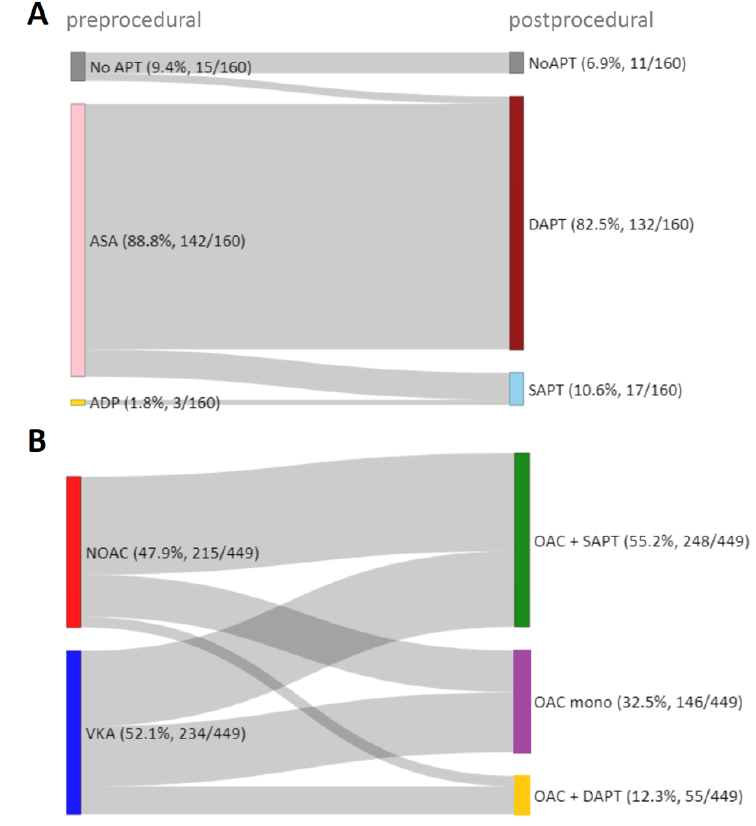
Figure 1. Pre- and postprocedural antithrombotic therapy. Sankey diagram illustrating the pre- and postprocedural antithrombotic therapy in successfully treated TEER patients without ( A ) and with ( B ) prior indication for oral anticoagulation. APT—antiplatelet therapy, ASA—acetylsalicylic acid, ADP—Adenosin-diphosphate receptor antagonists, SAPT—single antiplatelet therapy, DAPT— dual antiplatelet therapy, NOAC—nonvitamin k antagonist oral anticoagulant, VKA—vitamin k antagonist, OAC—oral anticoagulant. Table 1. Characteristics of patients after successful TEER stratified by postprocedural antithrom-